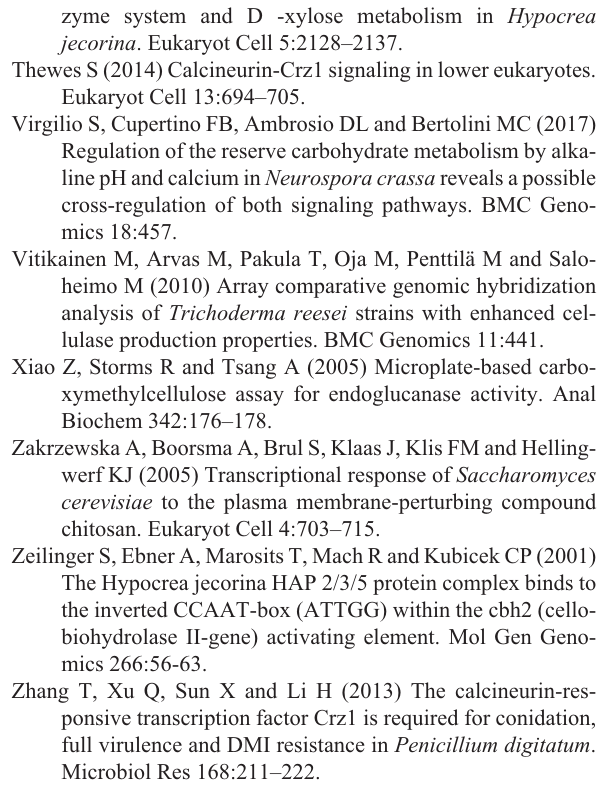
Figure S1 – Molecular procedures to confirm crz1 ORF dele- tion from T. reesei QM6a genome. Figure S2 – Expression profile of regulators and main cel- lulase from T. reesei . Figure S3 – Expression of holocellulases in response to Avicel. Relative expression of Figure S4 – Expression of (cid:6) -glucosidases genes of T. reesei. Figure S5 – Expression of endoglucanases and accessory proteins. Figure S6 – Expression of transporter genes. Figure S7 – Expression of transporters in response to SCB and Avicel. Figure S8 – Expression of additional holocellulases in re- sponse to